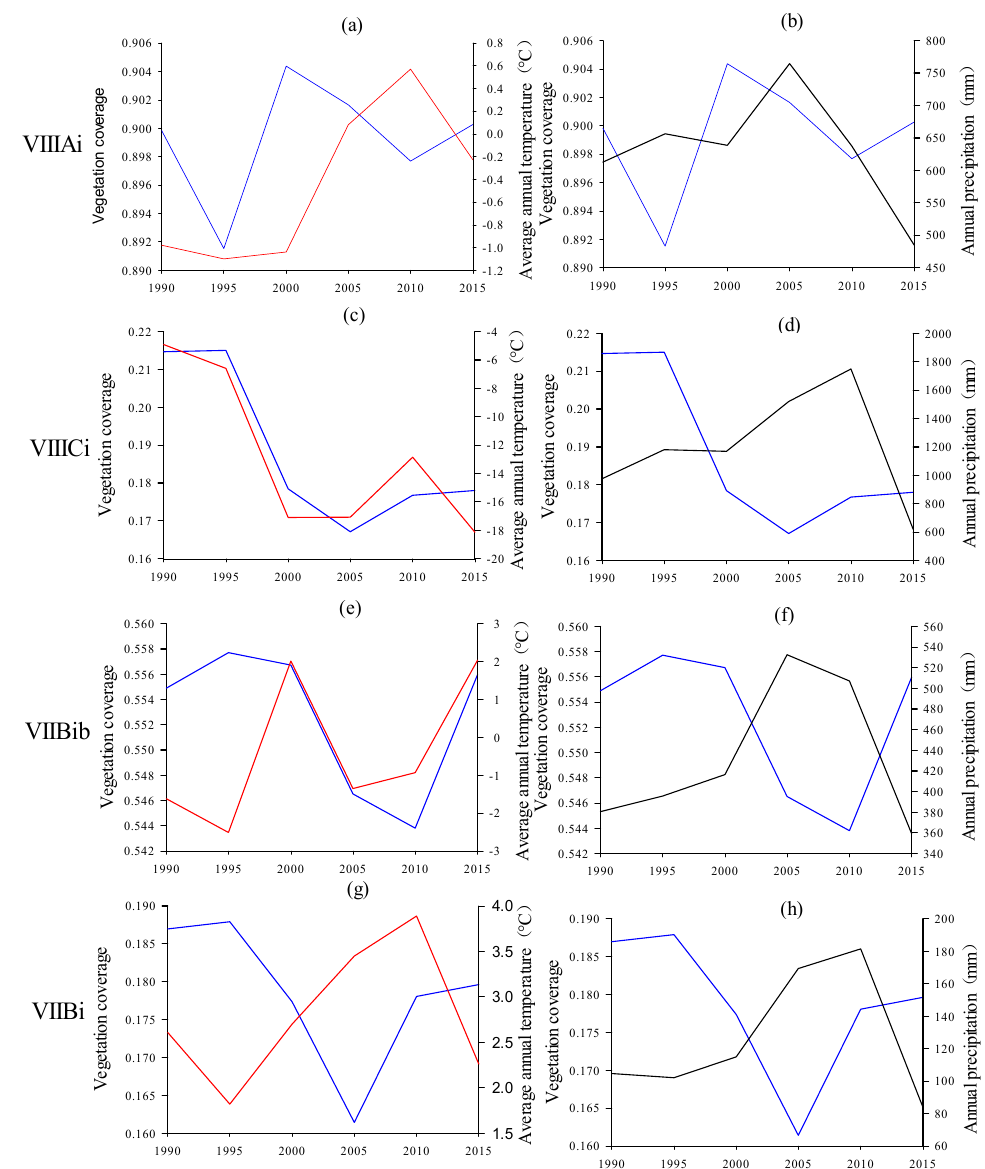
Figure 6. The change curves of vegetation coverage, average annual temperature, and annual precipitation in VIIIAi ( a , b ), VIIICi ( c , d ), VIIBib ( e , f ), VIIBi ( g , h ). The change curves of vegetation coverage, average annual temperature, and annual precipitation are, respectively, blue, red, and black.